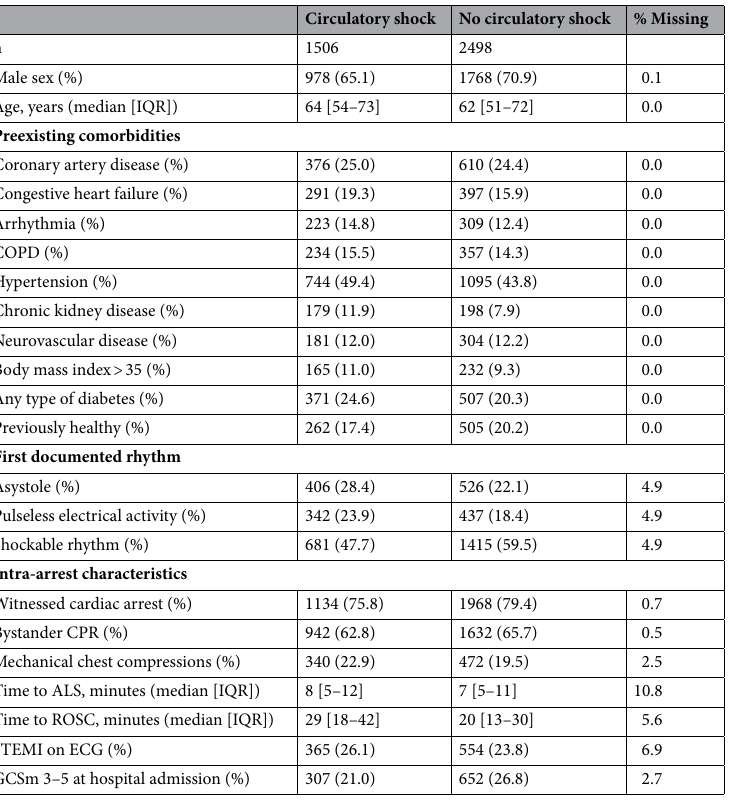
Table 1. Baseline characteristics stratified according to circulatory shock at hospital admission. Patients included in main analysis, n = 4004. Categorical data is presented as absolute counts and frequencies, continuous data as medians with interquartile range. IQR interquartile range; COPD Chronic obstructive pulmonary disease; CPR Cardiopulmonary resuscitation; ALS Advanced life support; ROSC Return of spontaneous circulation; STEMI ST-Elevation myocardial infarction; ECG Electrocardiogram; GCSm Glasgow coma score motor